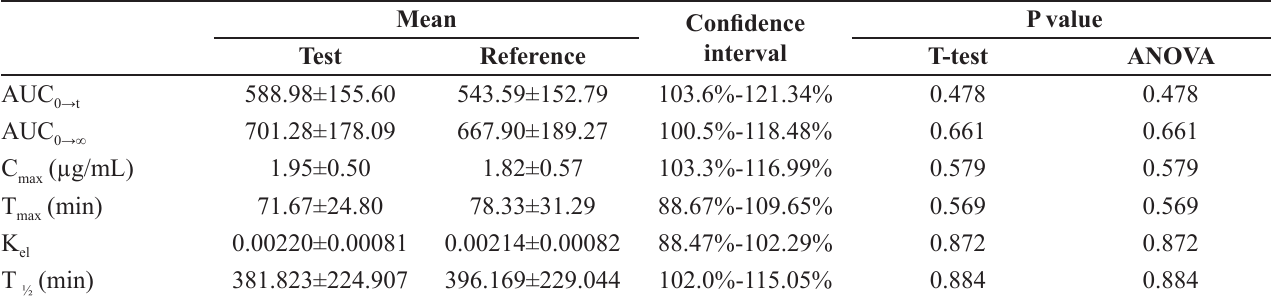
TABLE IV - Pharmacokinetic parameters of the gemifloxacin 320 mg test and reference